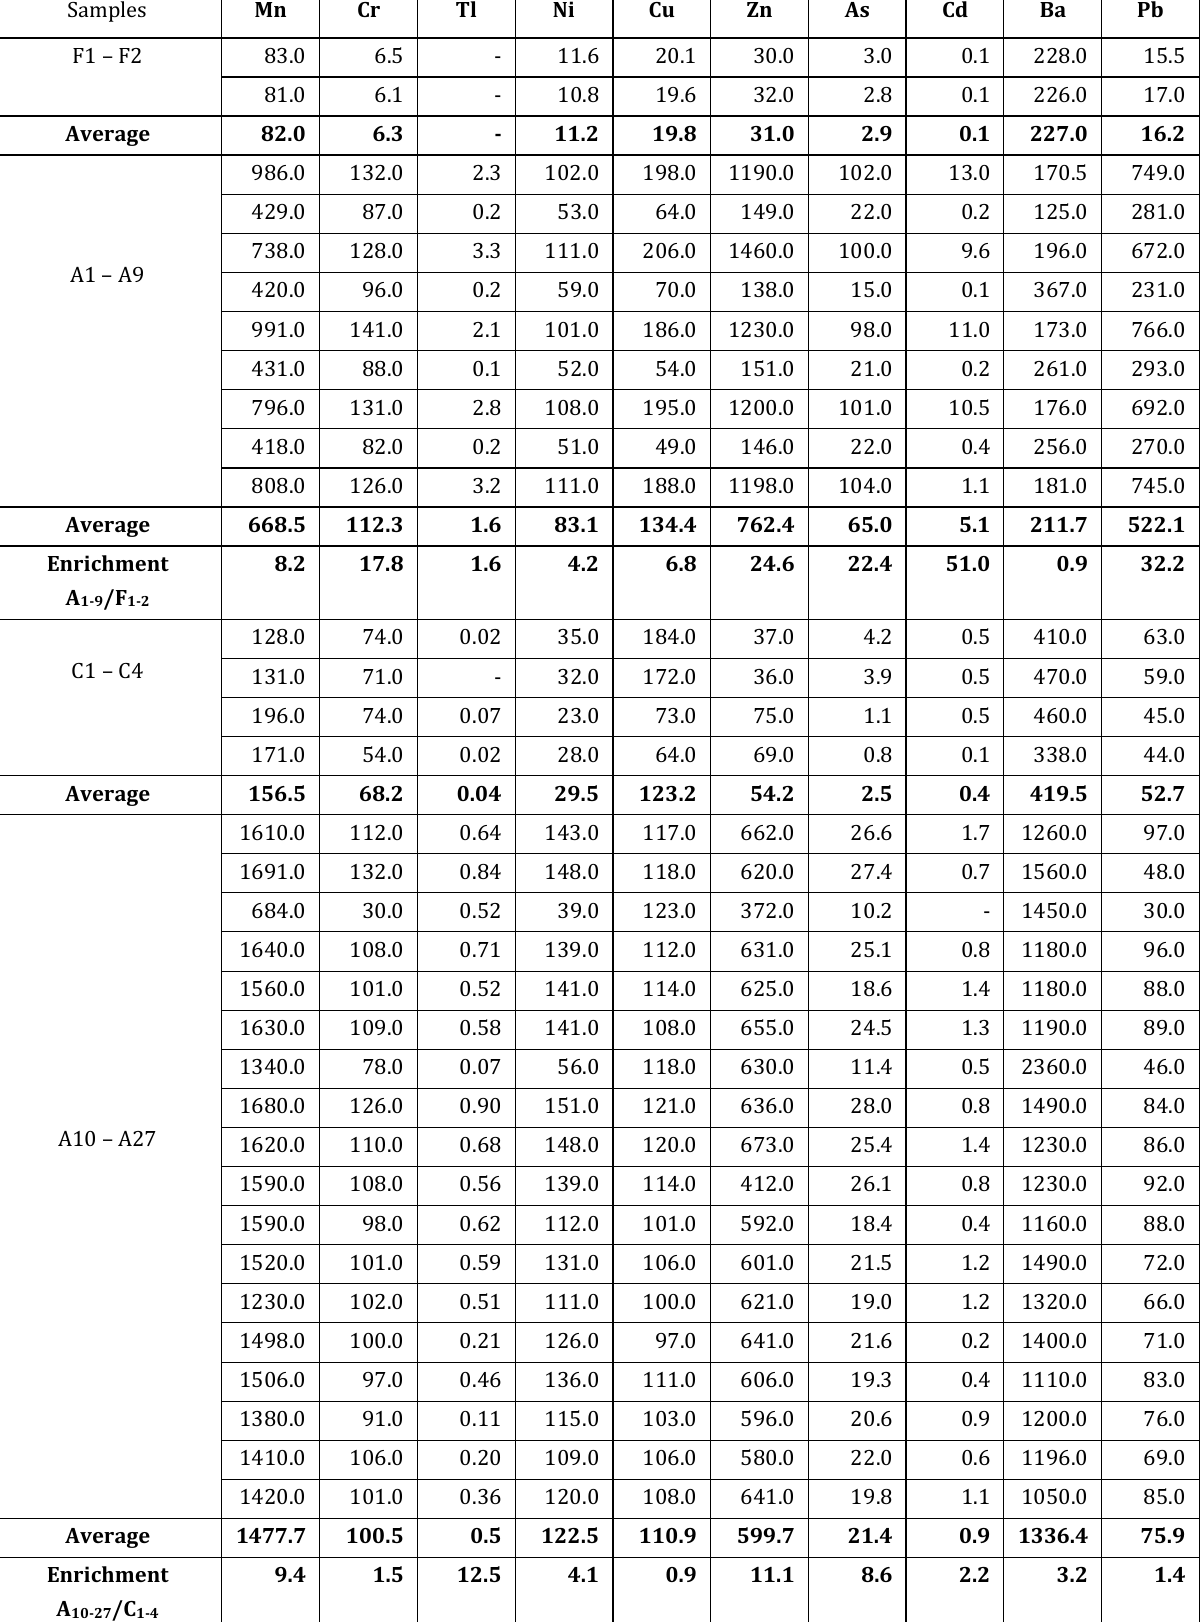
Table. 1. Trace elements (ppm) of ashes produced in the process of combustion of solid fuels in individual household furnaces in